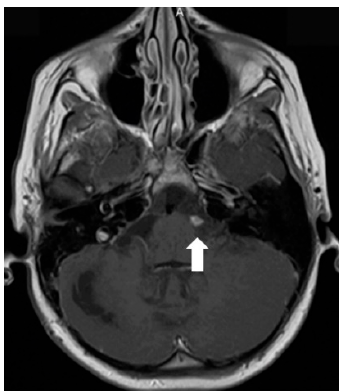
Figure 2. Follow-up MRI of the brain after the surgery (in December 2011). Axial post-contrast T1W image demonstrates a new enhancing nodule in the expected location of the cisternal segment of the left abducens nerve.